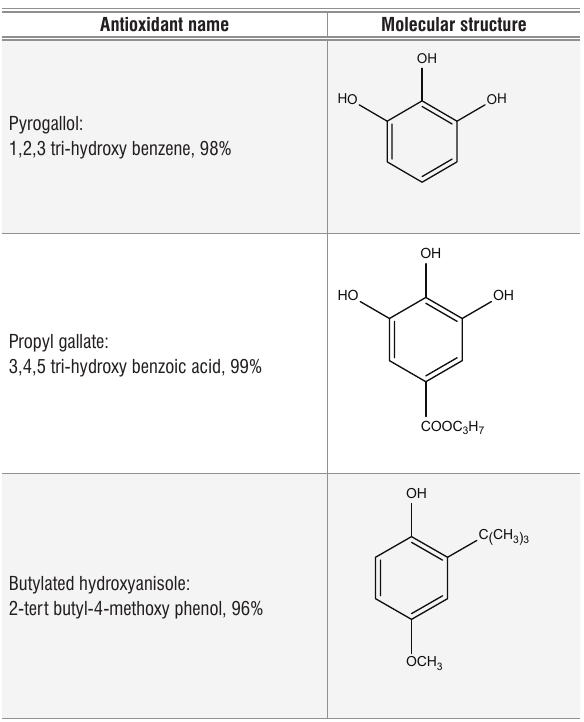
oxidised free radical to inhibit the rate of oxidation in methyl esters. The resulting antioxidant is a stable radical that can react with other fatty acid free radicals and further contribute to oxidation inhibition. 11